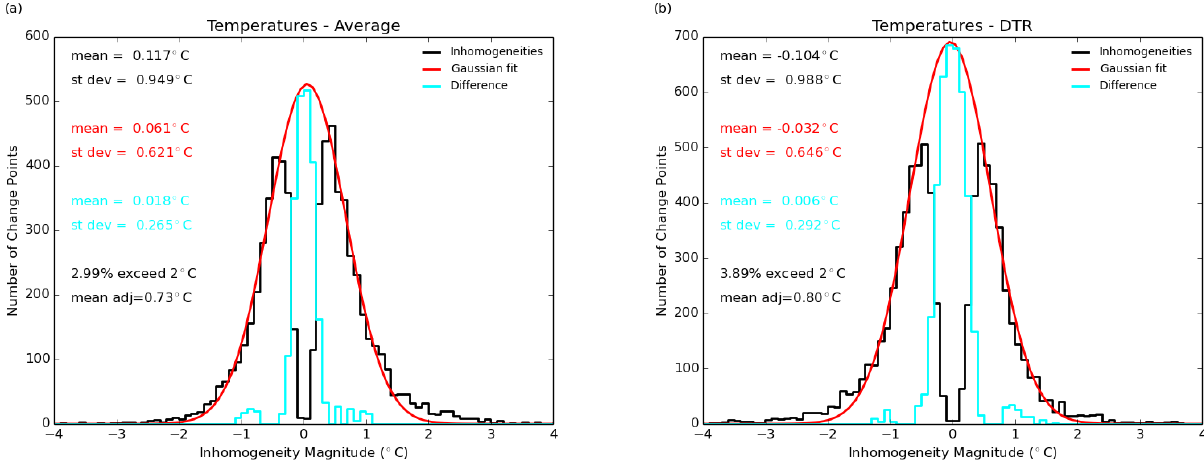
Figure 2. The distribution of the inhomogeneity magnitudes for monthly-mean (a) temperatures and (b) diurnal temperature range. The distributions have been fitted with a Gaussian (red), and the difference between the data and the Gaussian is shown in blue. A positive step means that the earlier homogeneous period (before the break) is spuriously warmer or has a spuriously larger diurnal temperature range than the later homogeneous period (after the break).